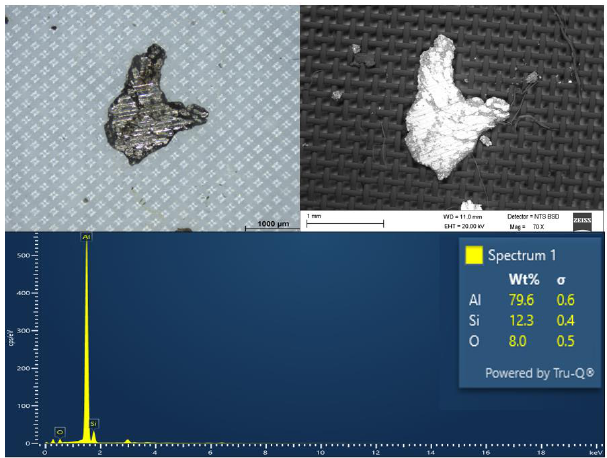
Fig. 7. Comparison of particle view from light microscopy (upper left) and SEM-EDX (upper right and